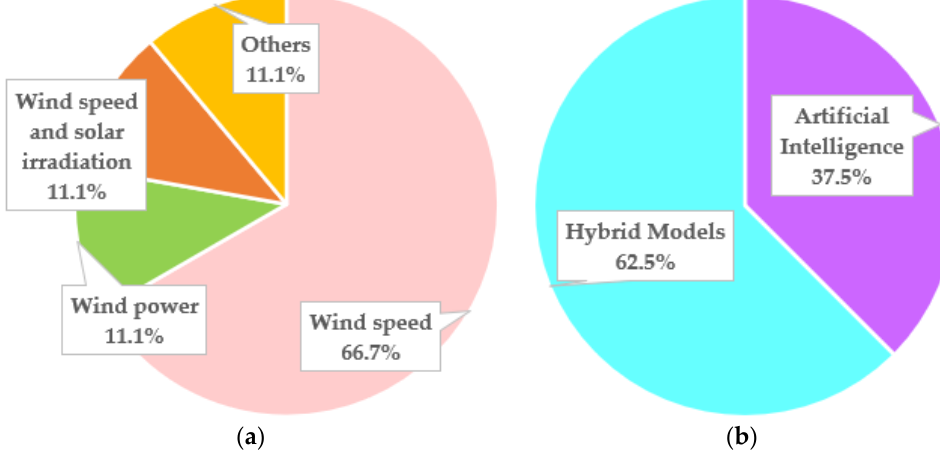
Figure 11. ( a ) Percentage distribution of the forecast objective of long-term models. ( b ) Percentage distribution of long-term forecasting methods.